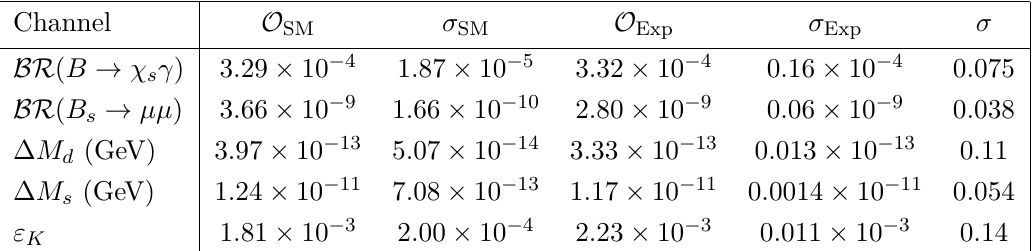
Table 1 . The measured QFV observables values and their respective uncertainties were taken from [69]. The SM prediction and the theoretical uncertainties are taken from Flavio